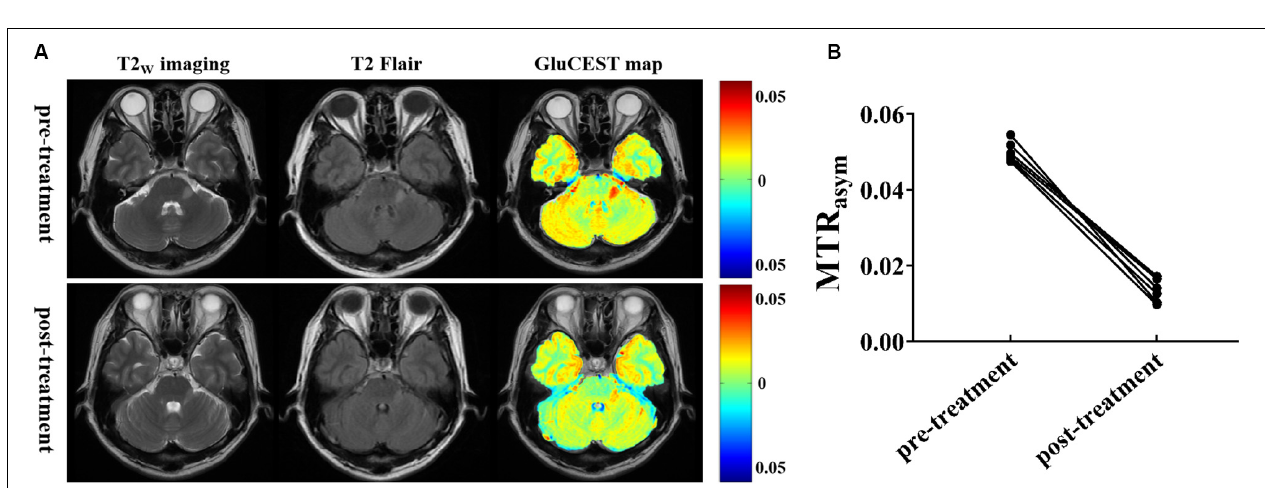
FIGURE 5 | Glutamate chemical exchange saturation transfer imaging was used for efficacy evaluation. (A) T2 W imaging, T2Flair, and GluCEST maps of a patient with encephalitis before and after intravenous immunoglobulin therapy. (B) Compared with pre-treatment, the magnetization transfer ratio (MTR asym ) value (GluCEST signal) at post-treatment was significantly decreased ( n = 6, Student’s t test, two-tailed, paired).